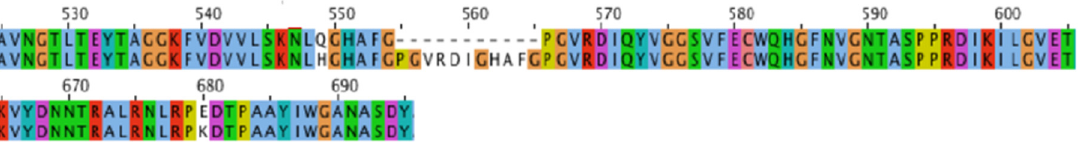
Figure 4. Amino acid sequence comparison of a section of the T7-like tail fiber protein gene of phage ϕ NV3 (top) and phage NV6 (below).